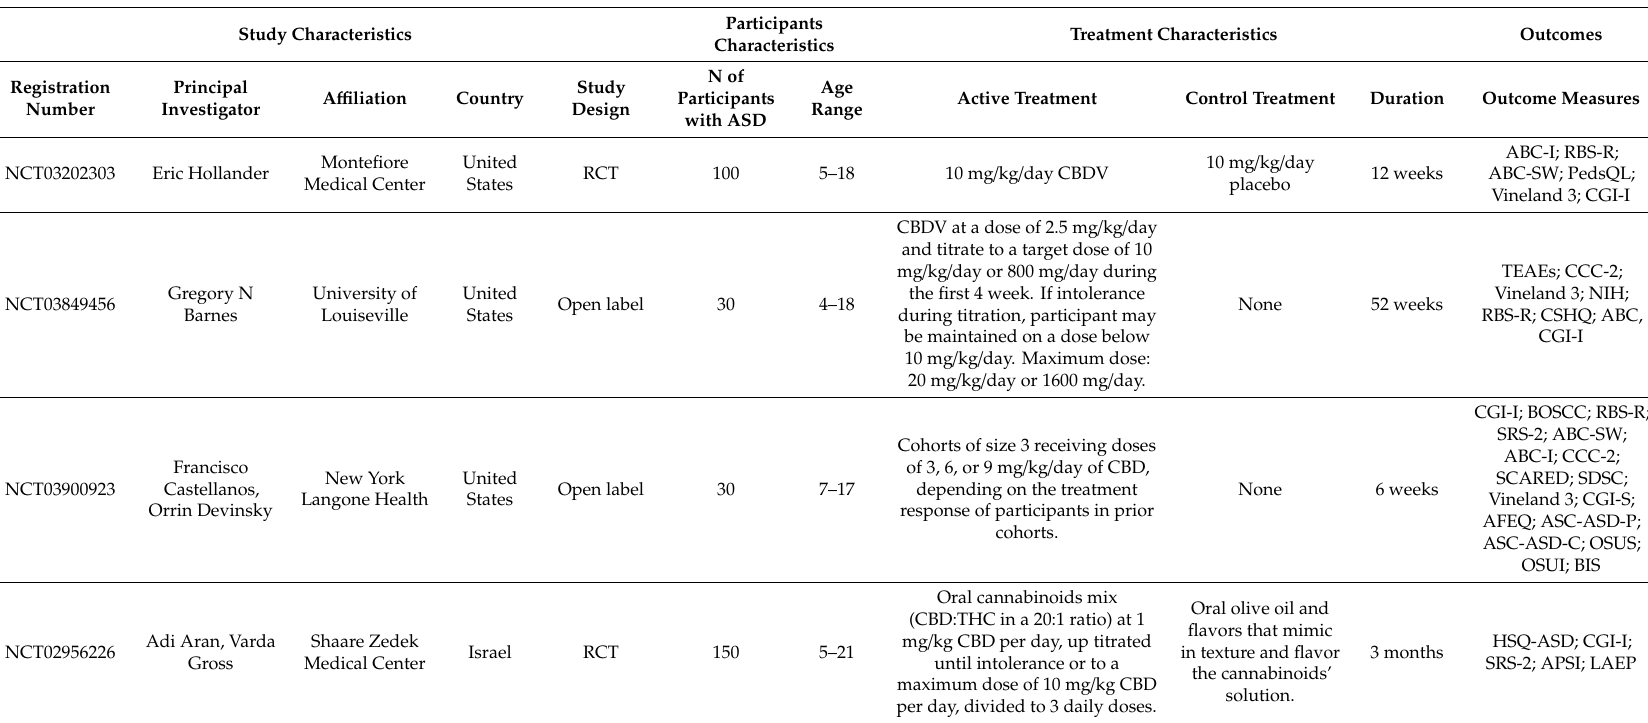
Table 3. Characteristics of ongoing trials testing cannabinoids in people with